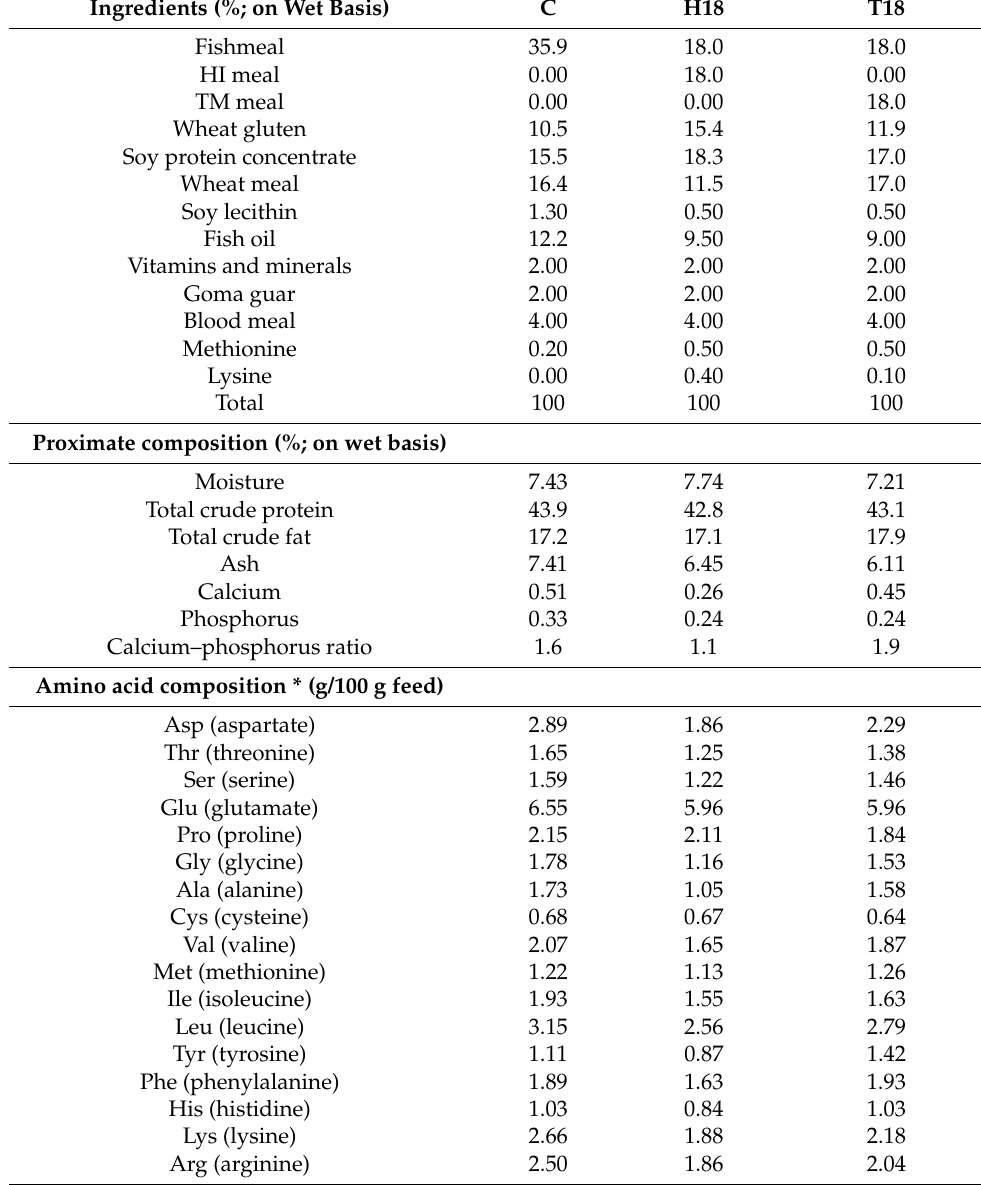
Table 2. Formulation, proximate, and amino acid composition of experimental diets. Ingredients (%; on Wet